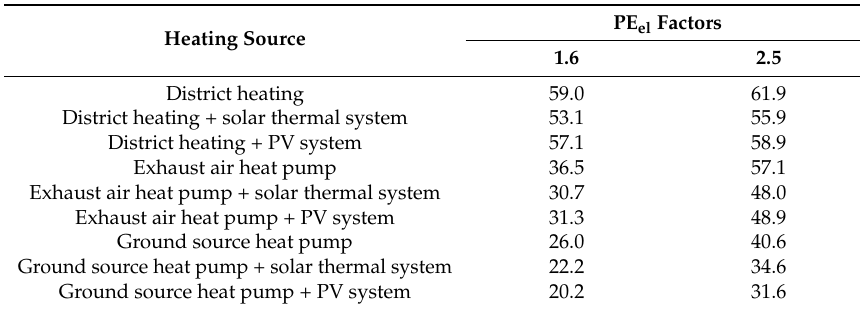
Table 5. The PE number for the two PE el factors and the different heating sources together with a 100 m 2 ST system or a 25 kW p PV system.